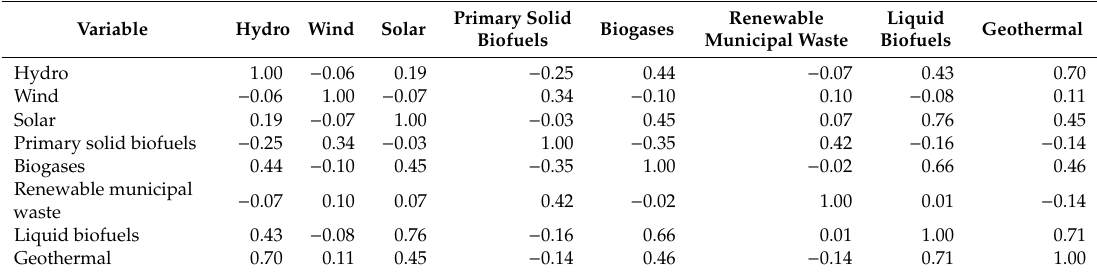
Table 11. Correlation coe ffi cients for energy production from renewable energy sources in the EU countries per GDP (according to nominal expenditure, in euro) in 2017 (own study). Variable